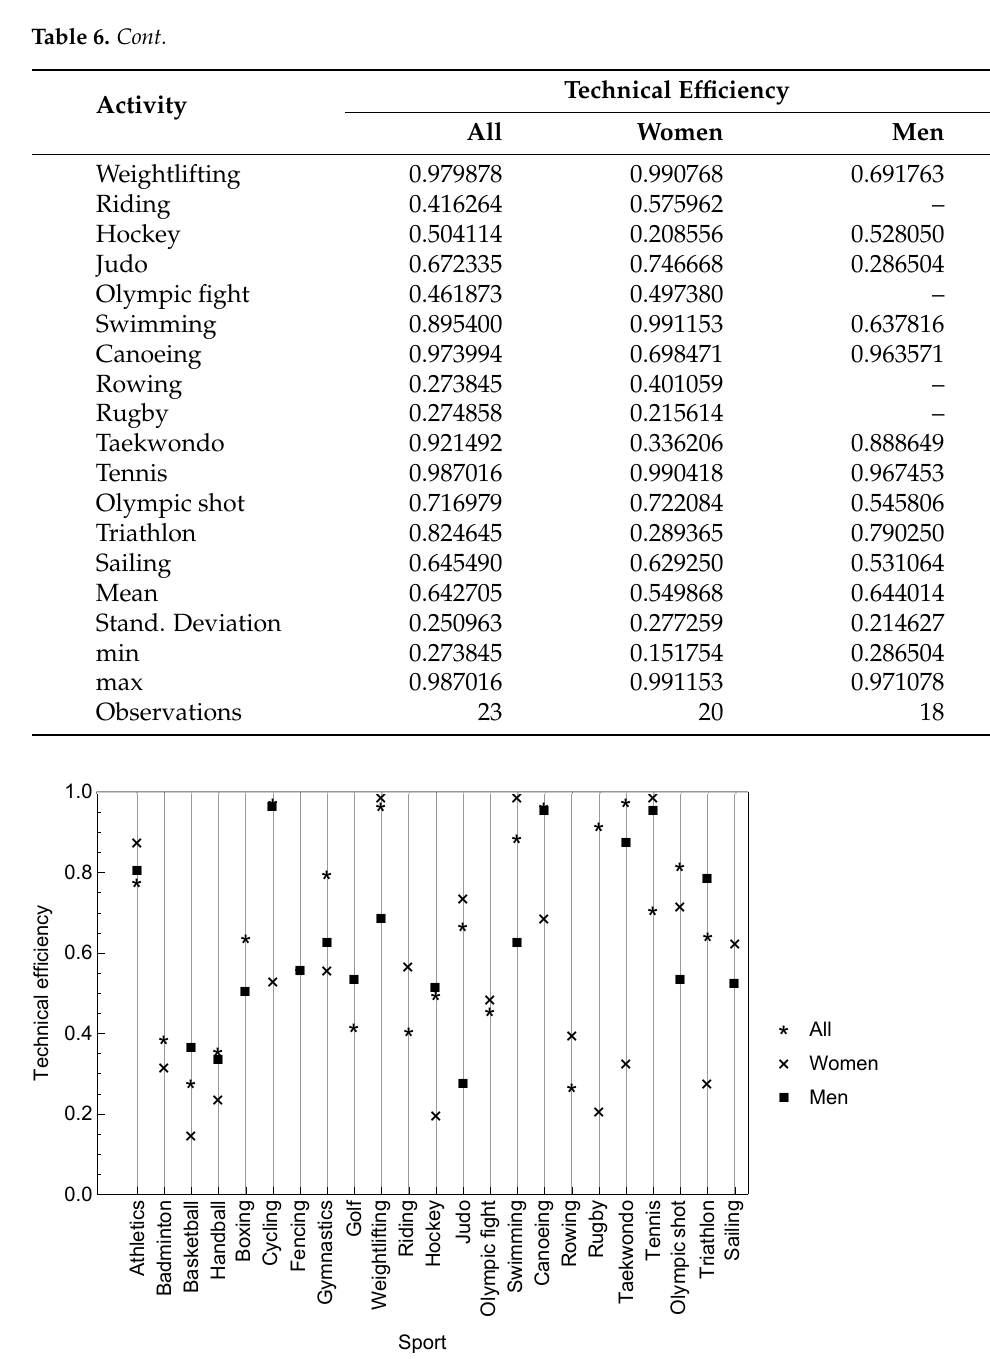
Figure 1. Technical efficiency in the period